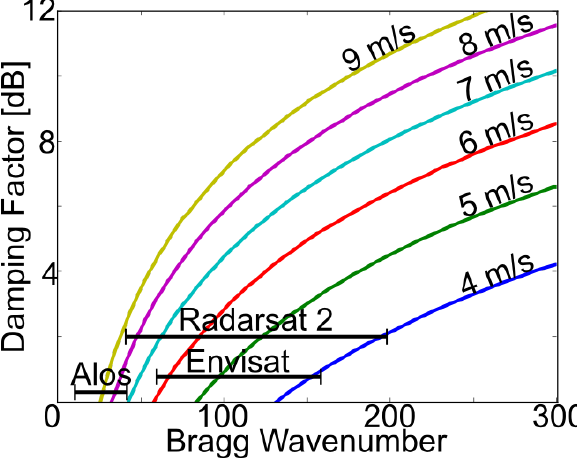
Figure 1. Estimated dampening factor as a function of Bragg wave number for common SAR sensors. The theoretical range of SAR systems used in the system are marked with horizontal lines. Each curve represents a different wind velocity. Wind speed and the angle between the radar look direction and wind play an important role in the dampening factor. Figure 2 shows a plot of expected dampening factors at speeds between 2.5 m/s and 12.5 m/s. The relative wind direction is plotted at counter-clockwise increasing angles, starting from zero at the horizontal axis. In this study we use the wind speed and direction data from QuickScat